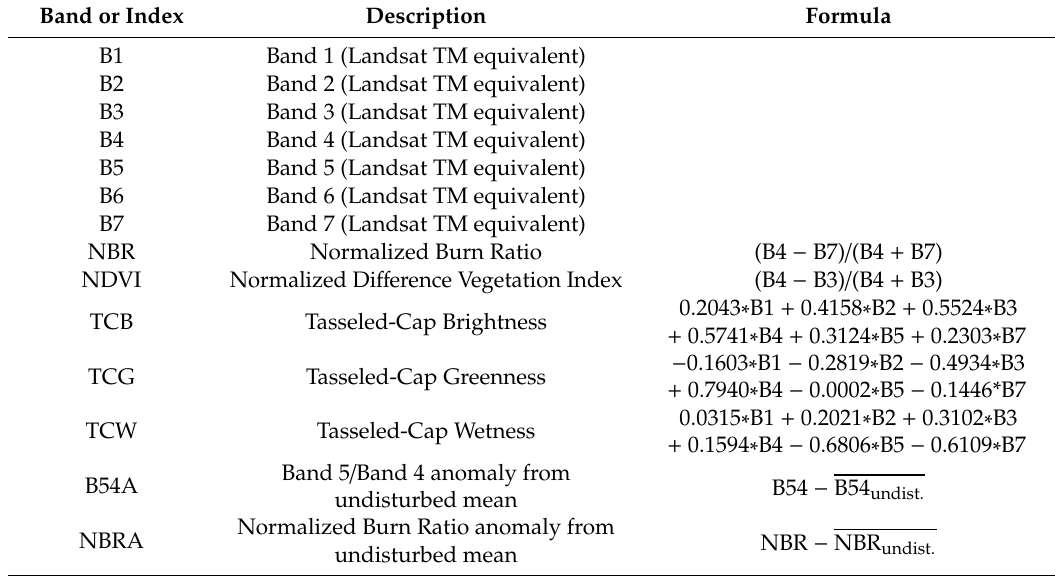
Table 2. Bands and spectral indices for which annual time series were created. Variables were used for classification and as candidate variables in Random Forest models predicting percent tree